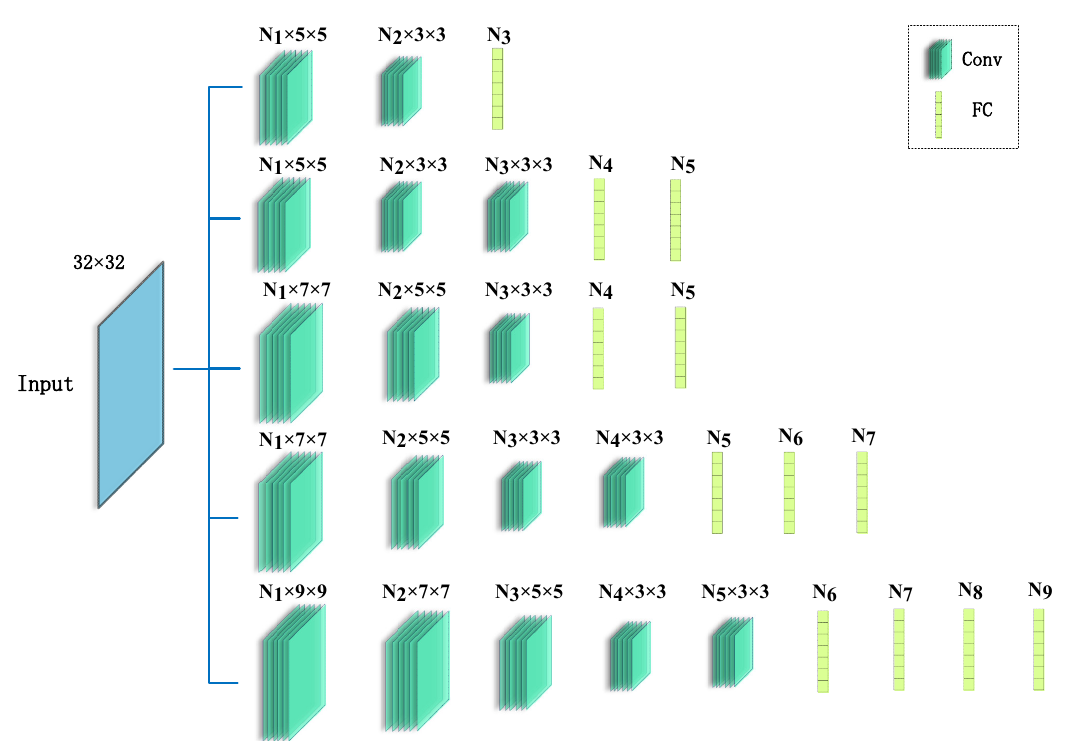
Figure 2. The hyper-parameters of the CNN involving convolutional layers, fully connected layers, number and size of filters.